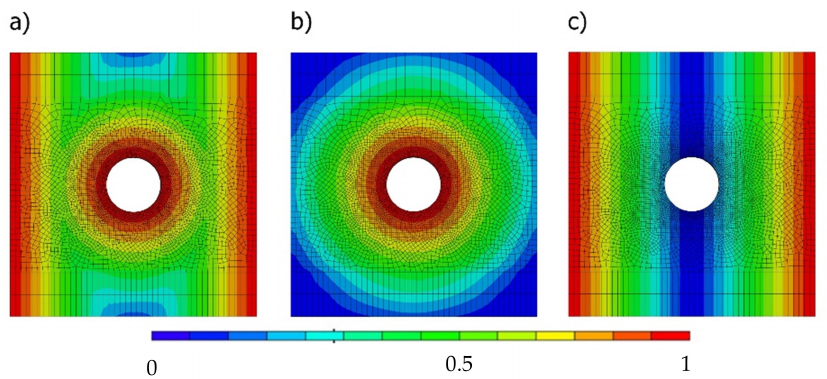
Figure 12. Seawater concentration after 900 immersion days with: ( a ) all permeable surfaces; ( b ) impermeable lateral surfaces; ( c ) impermeable hole surface.